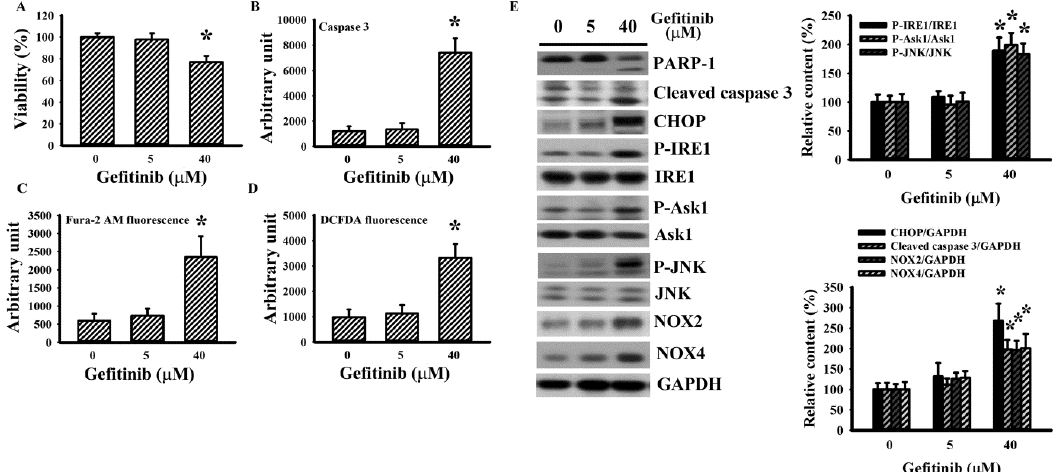
Figure 5. Gefitinib caused apoptosis and ER stress in U87 cells. U87 cells were treated with various concentrations of gefitinib (0–40 µ M). Cell viability (24 h) was measured with the alamarBlue assay ( A ). Caspase 3 activity (6 h) was measured with enzymatic assay ( B ). Intracellular free Ca 2+ (6 h) was measured with Fura-2 AM fluorescence ( C ). ROS (6 h) was measured with DCFDA fluorescence ( D ). Protein extracts (6 h) were subjected to Western blot with indicated antibodies. Representative blots of three independent experiments and quantitative data are shown ( E ). Protein contents were normalized with corresponding total protein or GAPDH. * p < 0.05 vs. untreated control, n = 4 ( A – D ).